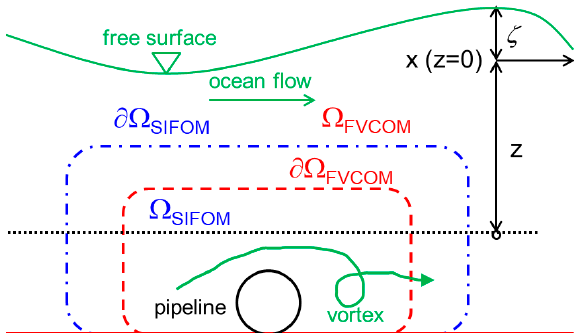
Figure 2. The decomposition domains of Solver for Incompressible Flow on the Overset Meshes–Finite Volume Coastal Ocean Model (SIFOM–FVCOM) modeling around the submarine pipeline.